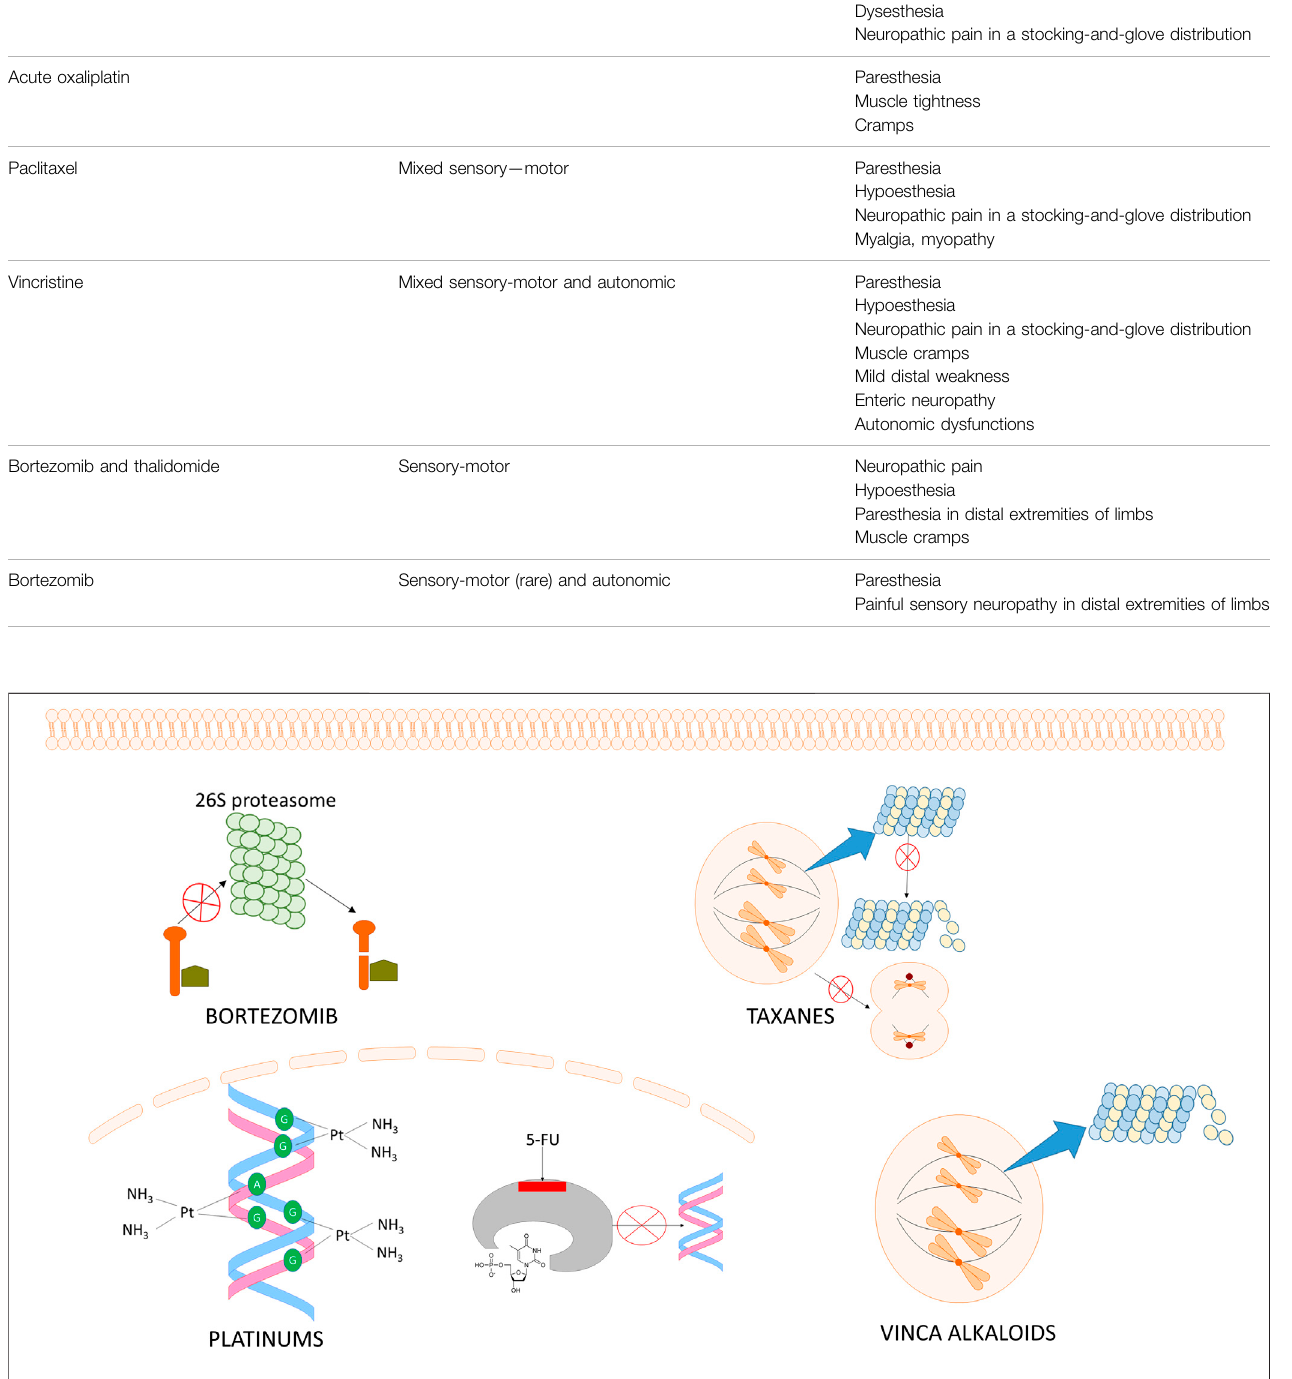
Frontiers in Pharmacology |